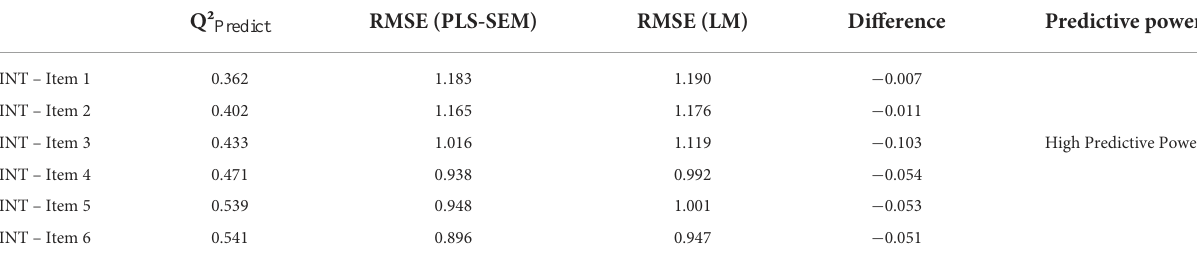
TABLE 7 Predictive model assessment.